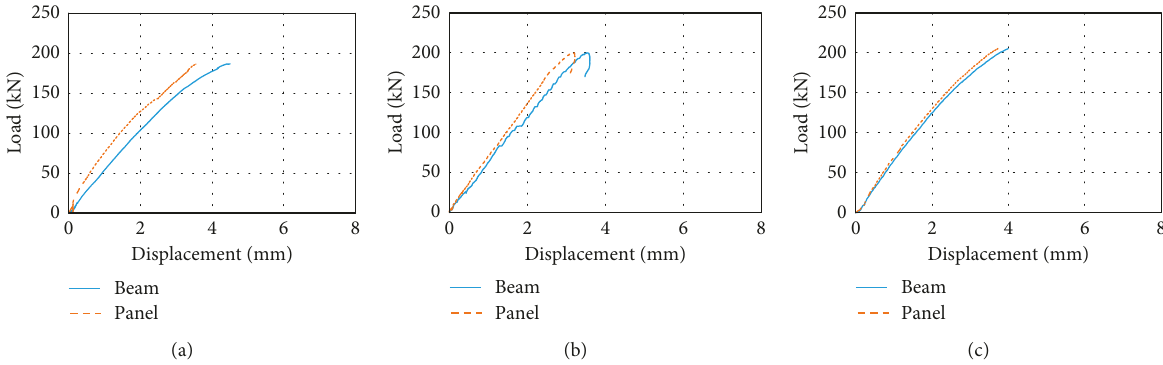
Figure 8: Load versus vertical displacement of the RC beam and panel of specimens with different fiber volume fractions. (a) 0F-8D12. (b) 1F-8D12. (c)